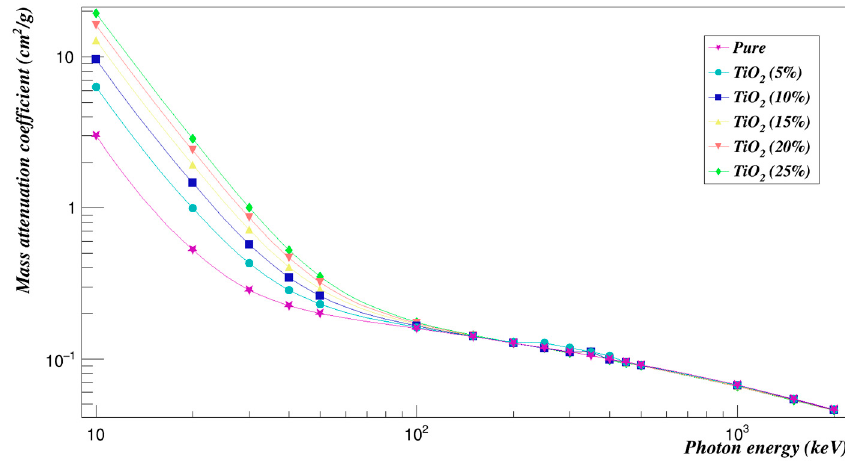
Figure 10. Photon mass attenuation coefficients of Polyimide doped with titanium dioxide.